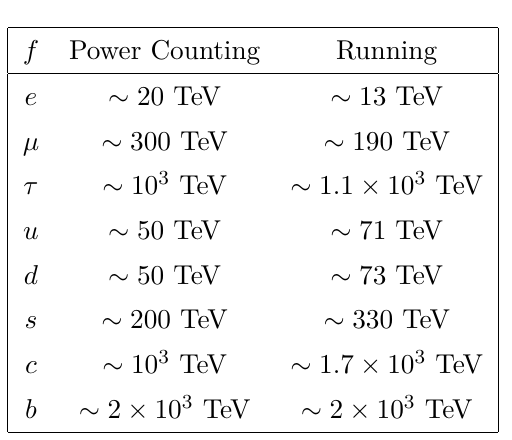
Table 4 . Powercounting estimates of the mixing from tensor to dipole operators below m W , compared to the solutions of the RGEs [10,